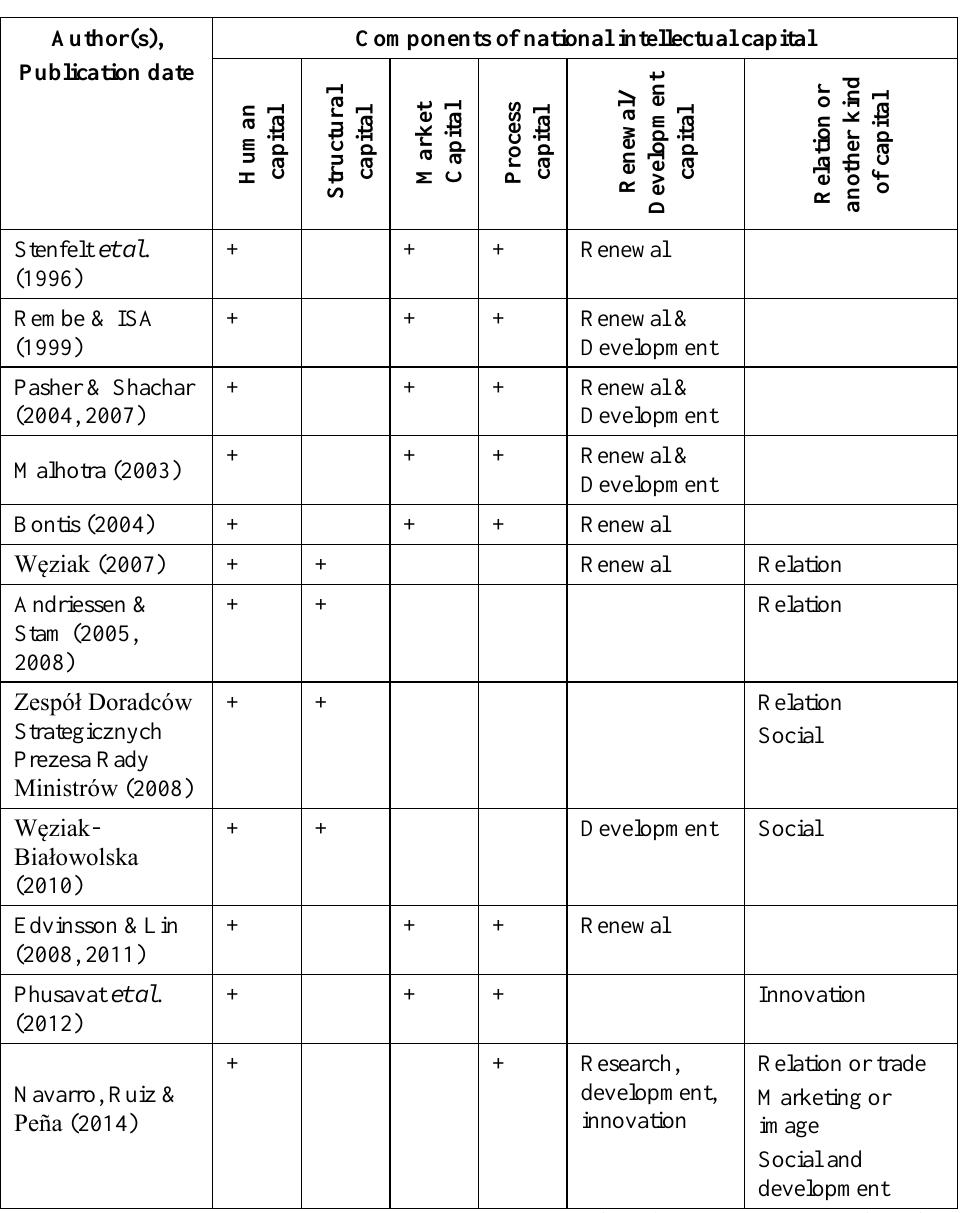
Table 2. Individual elements of national intellectual